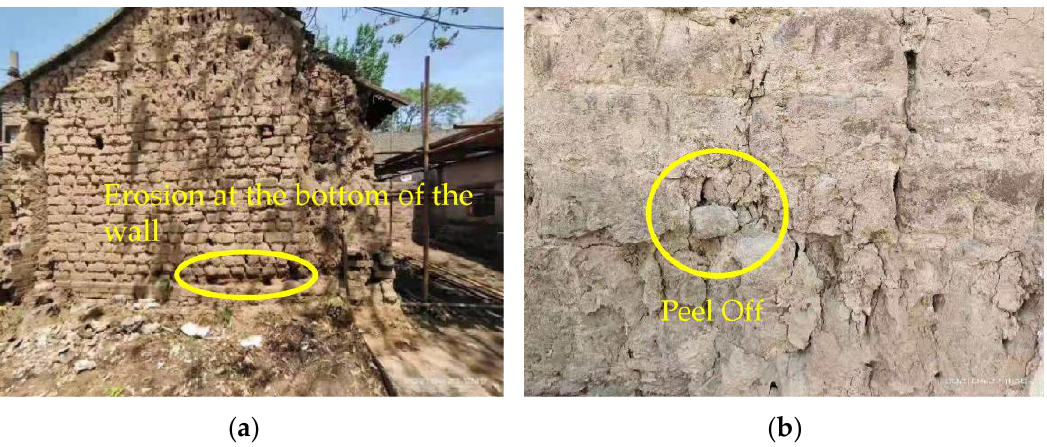
Figure 1. Disease map of cultural-relic buildings in western Henan : ( a ) erosion at the bottom of the wall; ( b ) peeling off the wall.